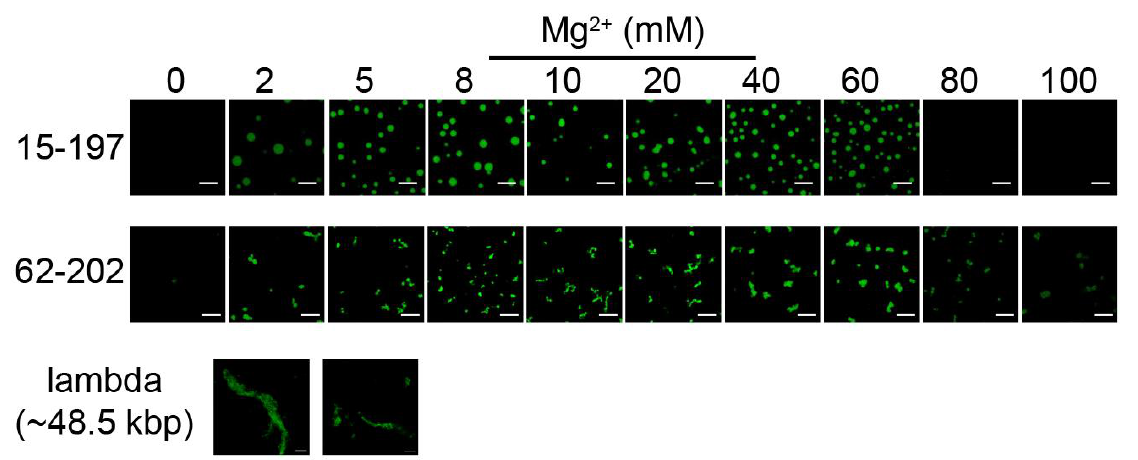
Figure 4. Reconstituted nucleosome array LLPS depends on chromatin fiber length. Confocal fluorescence microscopy images of nucleosome arrays reconstituted using 15-197-601, 62-202-601, lambda DNA (~48.5 kbp). Images of 15-197-601 and 62-202-601 nucleosome arrays were taken for samples in the presence of 100 mM KCl and various Mg 2+ concentrations. Images for lambda DNA nucleosome arrays were taken for samples at 0 mM (left) and 100 mM (right) KCl and in the absence of Mg 2+ , where solid-like condensates were observed (same as in the presence of Mg 2+ ). The nucleosome array concentrations are 375 nM. Scale bar represents 10 μ m. Images for samples at conditions with wider range of Mg 2+ concentrations are shown in Figure S10.